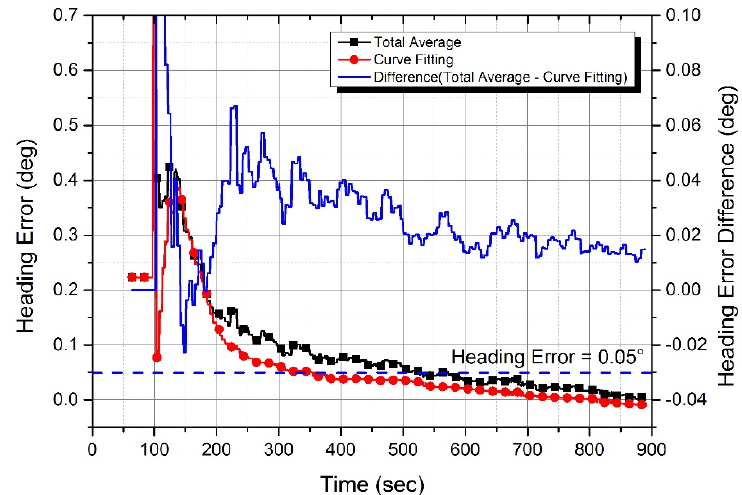
Figure 9. Heading error estimate from the INS experiment results. The red line converges to almost 0 ◦ smoothly, while the black line has local fluctuation, which is caused by a gyro random walk. The longer the total average time is, the less the fluctuation becomes. After 180 sec, the heading error of the curve fitting method is less than that of the total average method. The time needed for the heading error to reach within 0.05 ◦ is 355 sec for the curve fitting method, and 529 sec for the total average method.